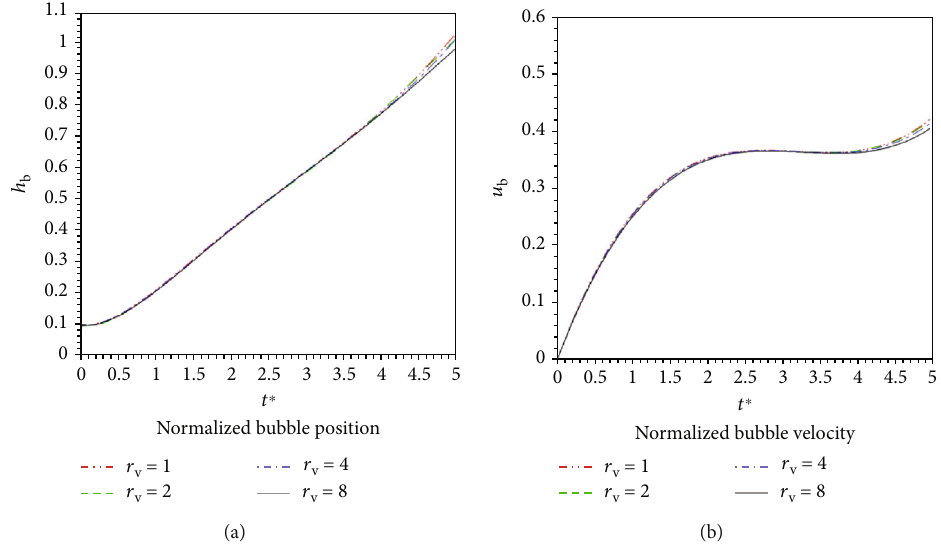
Figure 15: Temporal variations of the normalized bubble position and velocity for di ff erent viscosity ratios ( Re = 2048 and At = 0 : 5